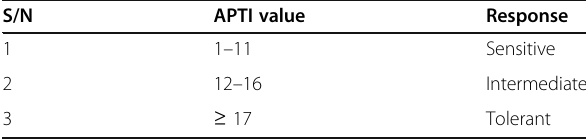
Table 1 Categories of plant species based on air pollution tolerance index S/N APTI